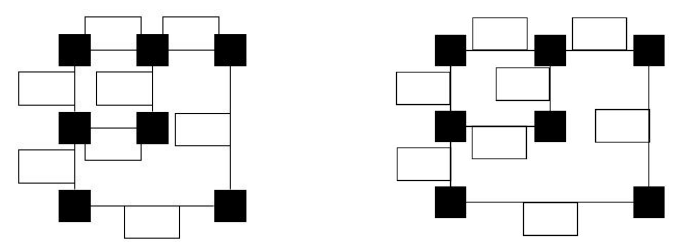
Figure 22. A sample orthogonal drawing where we resolve label overlaps by increasing only the width of the